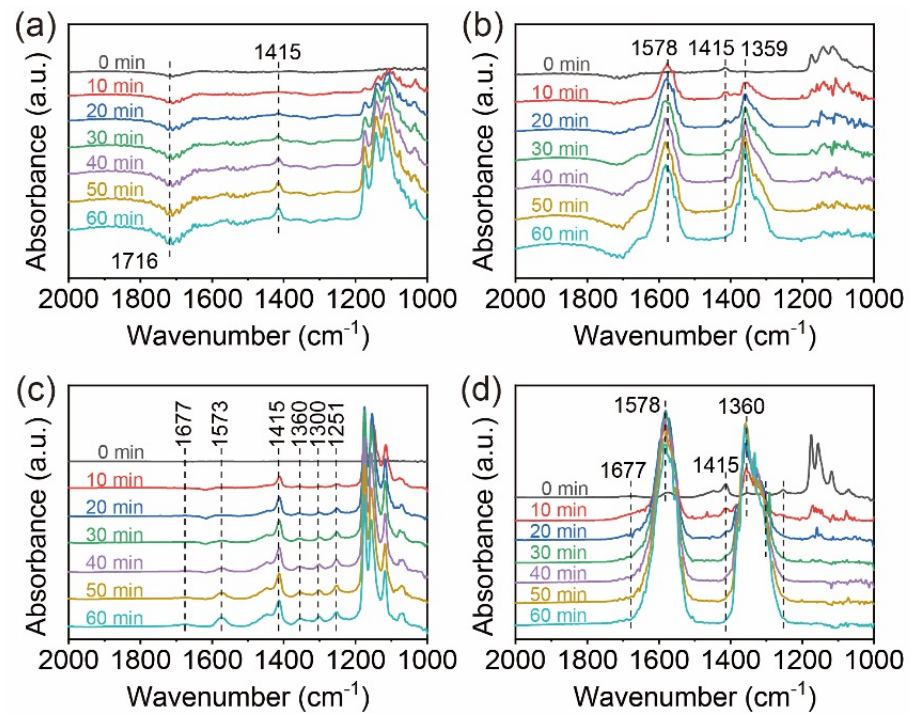
Figure 5. In situ DRIFT spectra of TiO 2 ( a ) before and ( b ) after illumination; C 60 -EDA/TiO 2 ( c ) before and ( d ) after illumination. Table 1. Infrared bands of surface species on TiO 2 or C 60 -EDA/TiO 2 , Derived from Figures 5 and S12.